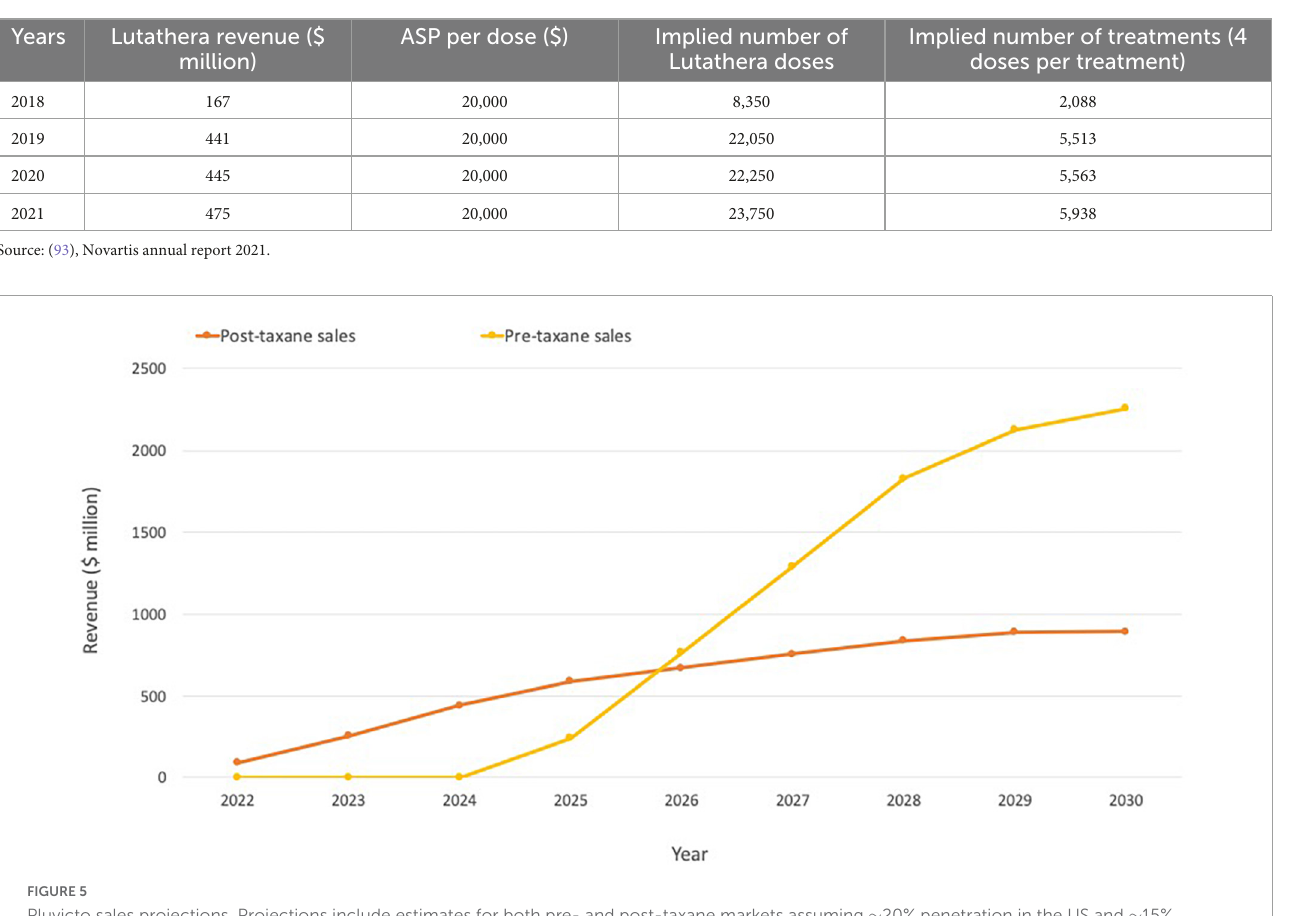
TABLE 2 Lutathera revenue and estimated number of doses and treatments for the period 2018–2021.